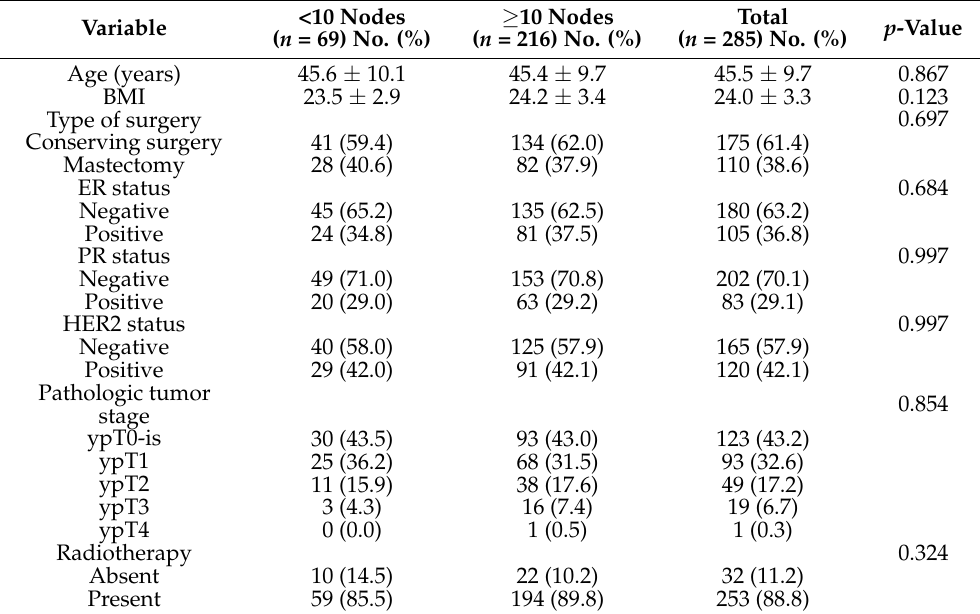
Table 2. Characteristics of the pathologic node-negative patients’ group according to lymph node dissection number.